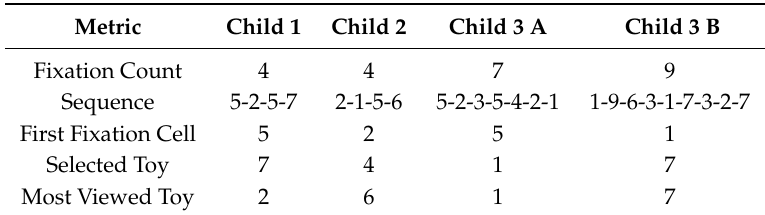
Table 5. Final outcomes of the proposed